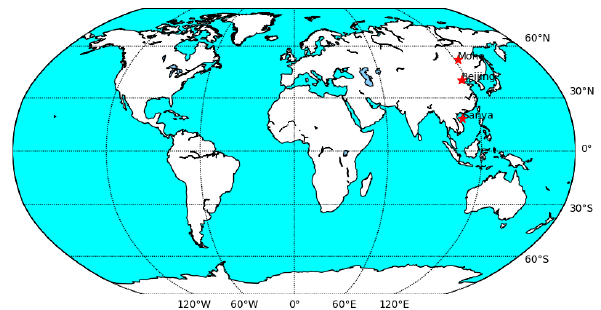
Figure 1. Geographic location diagram of Sanya, Beijing and Mohe station.